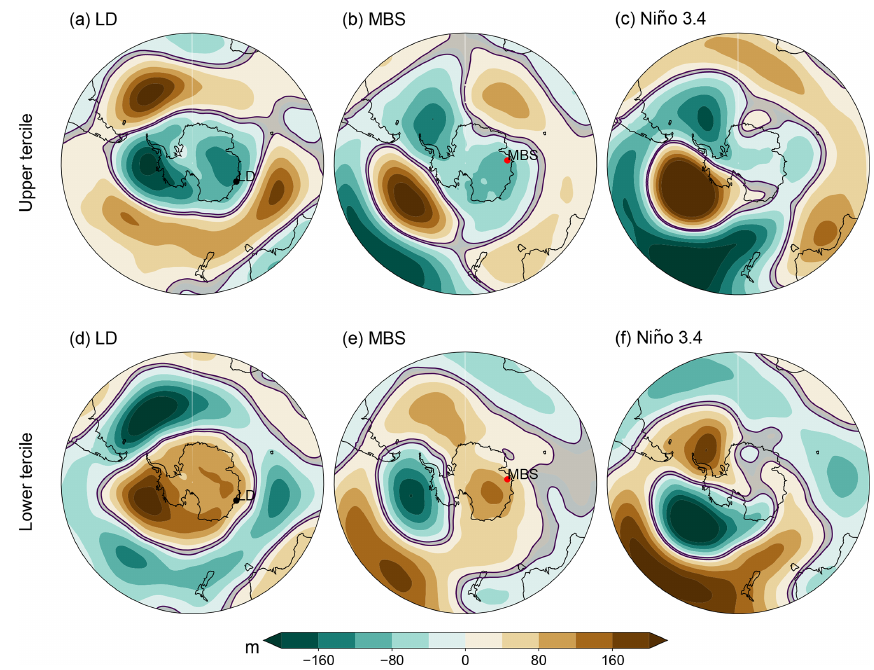
Figure 8. Geopotential height composite anomaly maps (metres at Z 500) during the upper (a) and lower (d) tercile (November–February) of the detrended, log-transformed summer sea salt concentrations from the Law Dome (LD, Dome Summit South site) record over 1979–2015. (b, e) The same as (a) and (d) except using the detrended, log-transformed annual sea salt concentrations from the Mount Brown South (MBS) site average (June–November) over the period 1979–2016. (c, f) The same as (b) and (e) except using the detrended Niño 3.4 Index (June–November). The red dot indicates MBS, and the black dot indicates LD. Significant anomalies are within the upper and lower purple contour lines, where p <